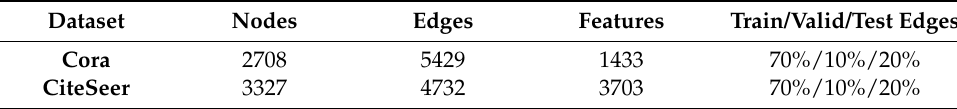
Table 1. The split details of two datasets in this